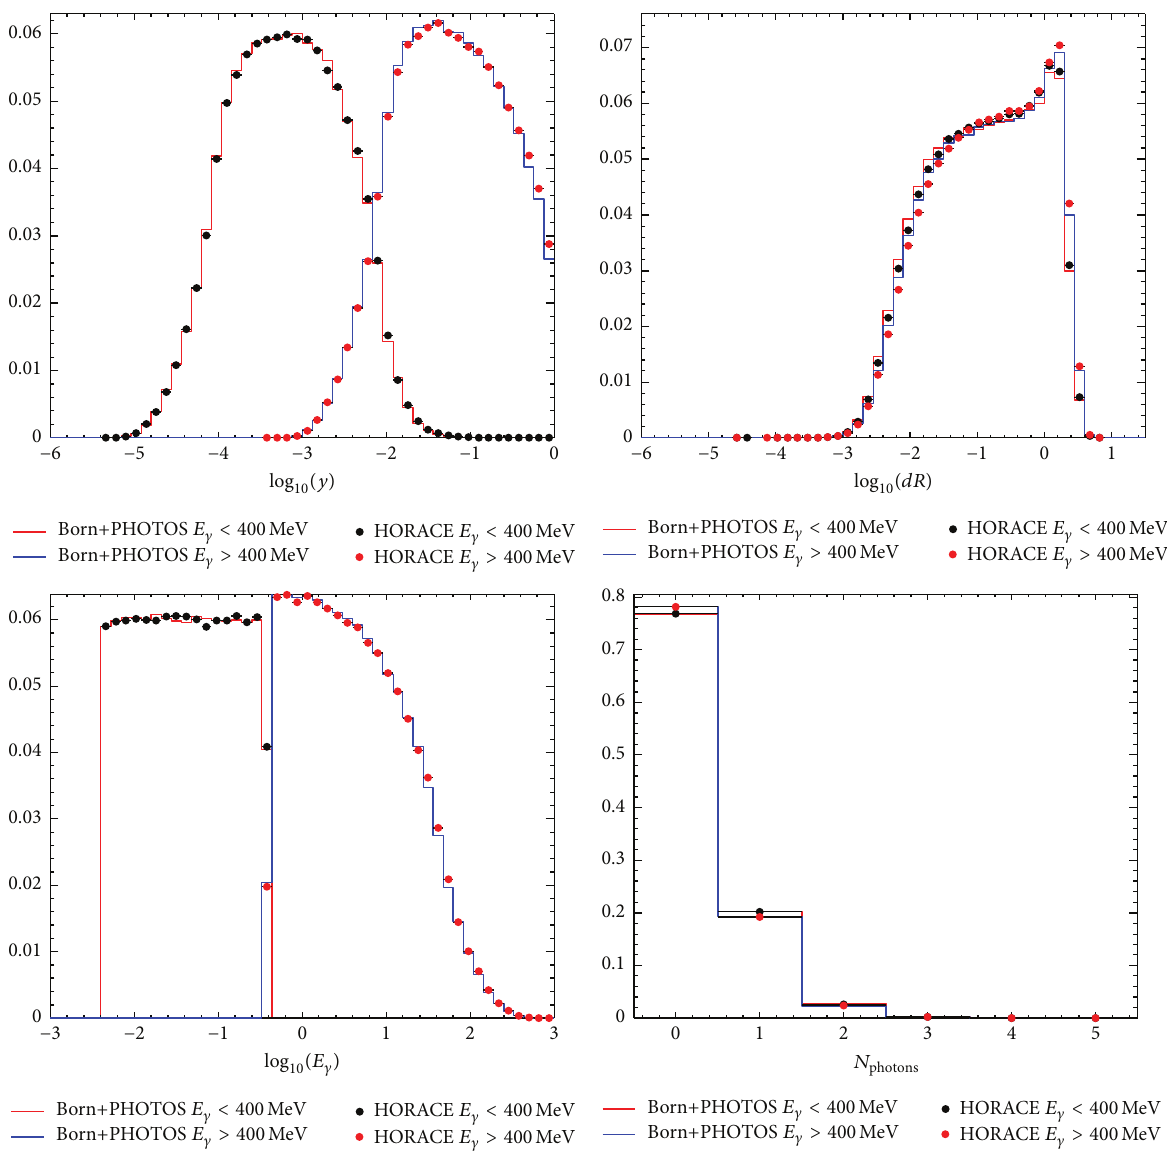
Figure 6: Clockwise from top-left: comparisons of the distributions of log 10 (𝑦 𝛾 ) , log 10 (Δ𝑅(𝑙𝛾)) , 𝑛 𝛾 , and log 10 (𝐸 𝛾 / GeV) for the 𝛾 ∗ /𝑍 → < 400 MeV) and high-energy ( 𝐸 > 400 MeV) photons. The smaller of the two Δ𝑅 values with 𝜇 + 𝜇 − + 𝑛𝛾 process, separated into low ( 𝐸 𝛾 𝛾 respect to the two muons is